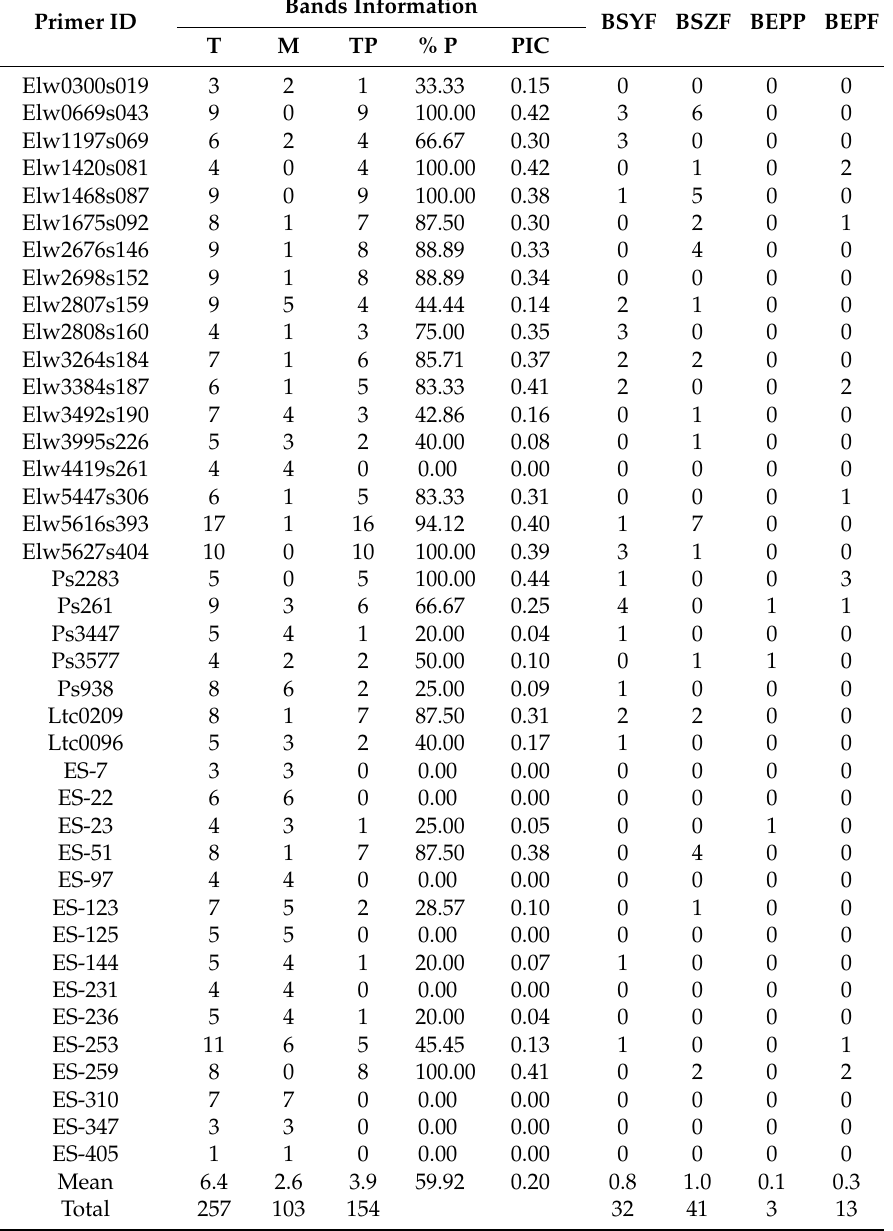
Table 7. Results achieved by Elymus (Elw), Pseudoroegneria (Ps), Leymus (Lt) and E. sibiricus (ES) EST-SSR markers, all detected in two parents and seven F 1